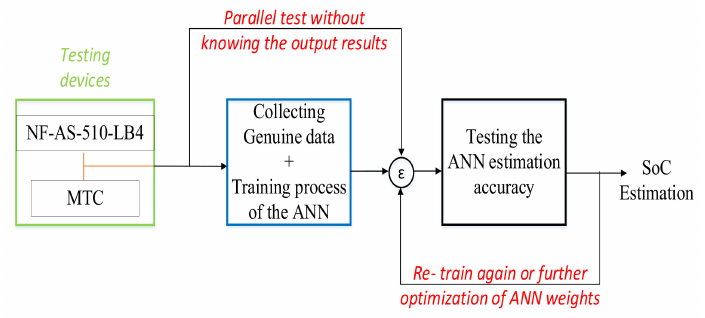
Figure 22. Block diagram of the data